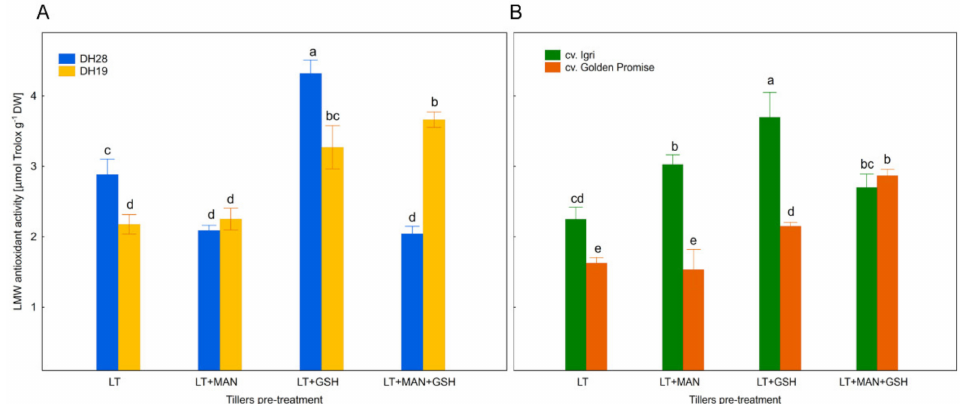
Figure 1. Total activity of low molecular weight (LMW) antioxidants in microspores of ( A ) two DH triticale lines (responsive DH28 and recalcitrant DH19) and ( B ) two barley cultivars of (responsive cv. Igri and recalcitrant cv. Golden Promise) isolated after various tiller pre-treatments. Data represent means of at least four measurements of two independent samples, each collected from at least 6 different spikes ± SE. Values marked with the same letter do not differ significantly according to Duncan’s multiple range test ( p ≤ 0.05). Please see Figure 3, LT—low temperature tiller pre-treatment (21 days at 4 ◦ C); LT+MAN—low temperature tiller pre-treatment combined with the application of 0.3 M mannitol; LT+GSH—low temperature tiller pre-treatment combined with the application of 0.3 mM reduced glutathione; LT+MAN+GSH—low temperature tillers pre-treatment combined with the application of 0.3 M mannitol and 0.3 mM reduced